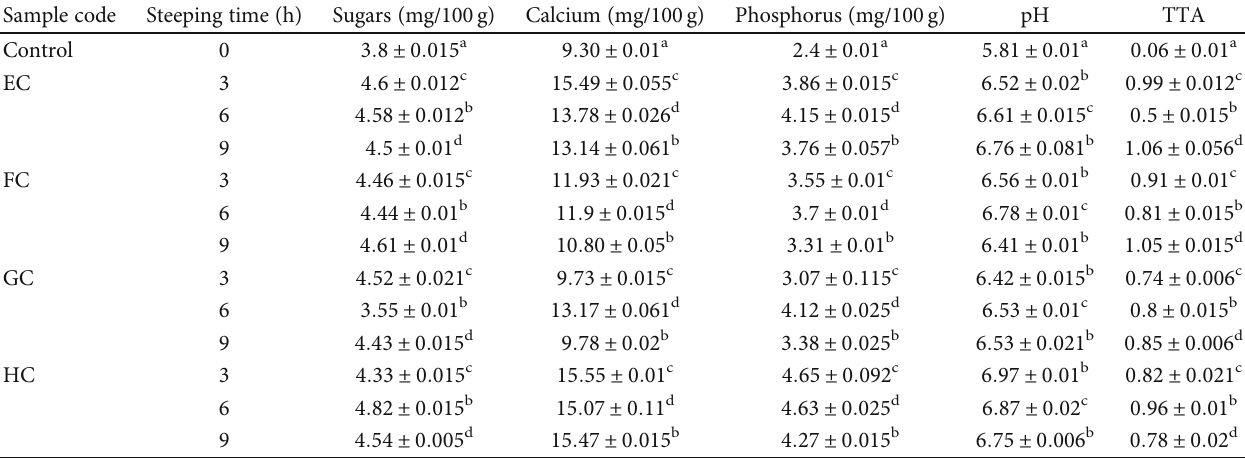
Table 3: Biochemical composition of the cassava-cowpea-orange- fl eshed sweet potato (OFSP) blend. Sample code Steeping time (h) Sugars (mg/100 g) Calcium